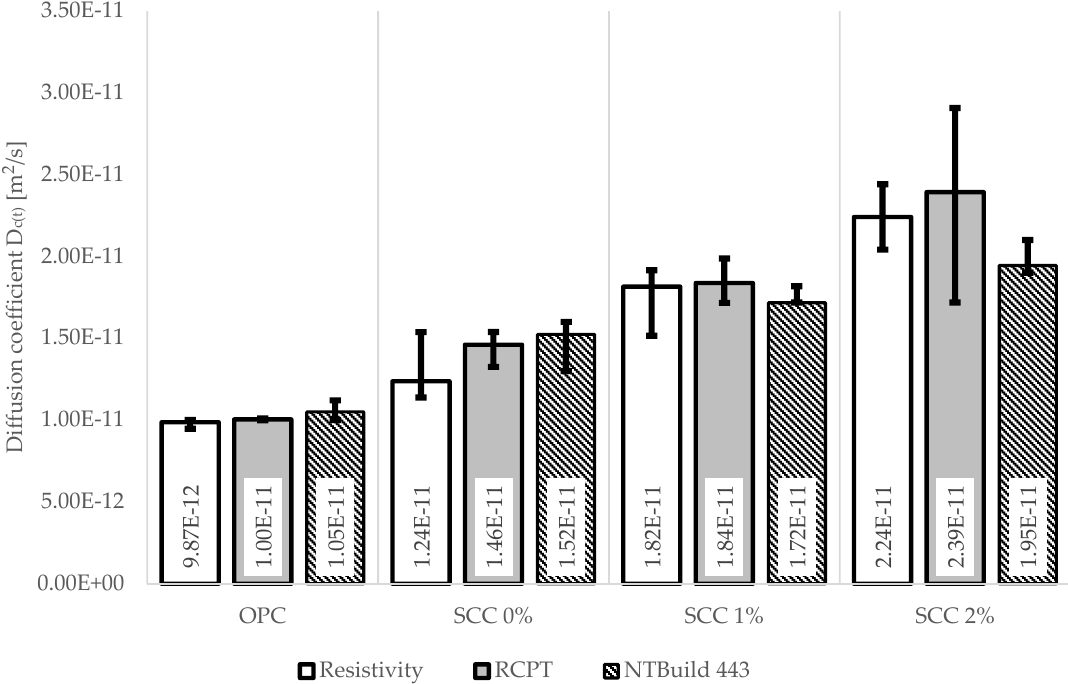
Figure 6. Diffusion coefficient D c(t) derived from surface resistivity, rapid chloride permeability test (RCPT) and chloride profile analysis (NTBuild 443). The minimum and maximum values are shown in the form of a T ‐ graph. Table 2. Statistical data of diffusion coefficient D c ( t ) derived from surface resistivity, rapid chloride permeability test (RCPT) and chloride profile analysis (NTBuild 443).